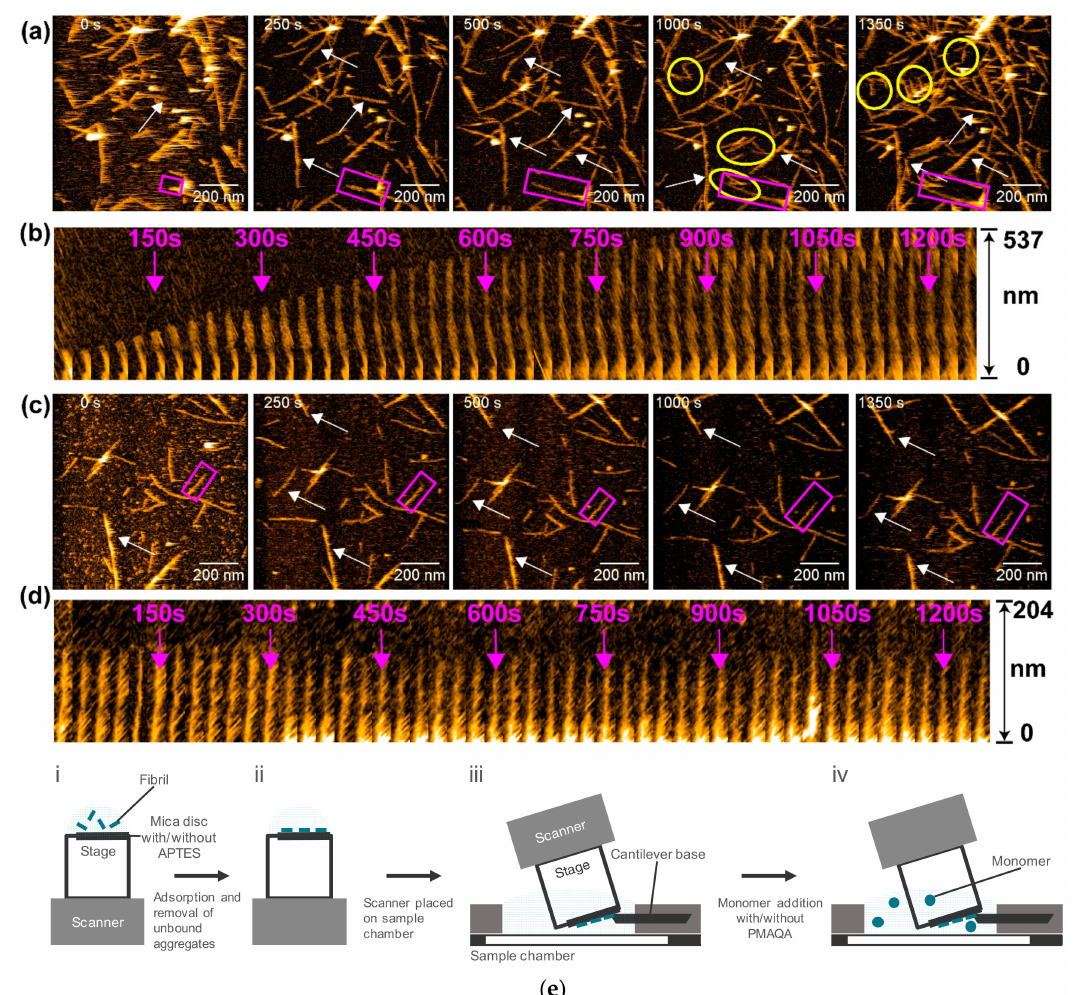
Figure 12. HS-AFM observation of amylin fibril growth. ( a , c ) HS-AFM images of the amylin seeding reaction in the absence ( a ) or presence ( c ) of polymethacrylate-derived copolymer (PMAQA). The de novo nucleated fibrils are highlighted by yellow circles in ( a ). The growth extents of fibrils are indicated by the white arrows. ( b , d ) Kymographs of individual amylin fibrils highlighted by purple boxes in ( a ) and ( c ) in the absence ( b ) or presence ( d ) of PMAQA. The experimental setups are shown in ( e ). Reprint with permission [116]: Copyright (2019), the Royal Society of